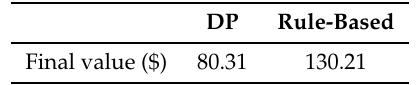
Figure 11. The battery state of charge in scenario 3 ( a ) the DP approach; ( b ) the rule-based method. Table 4. The final value in scenario 3.